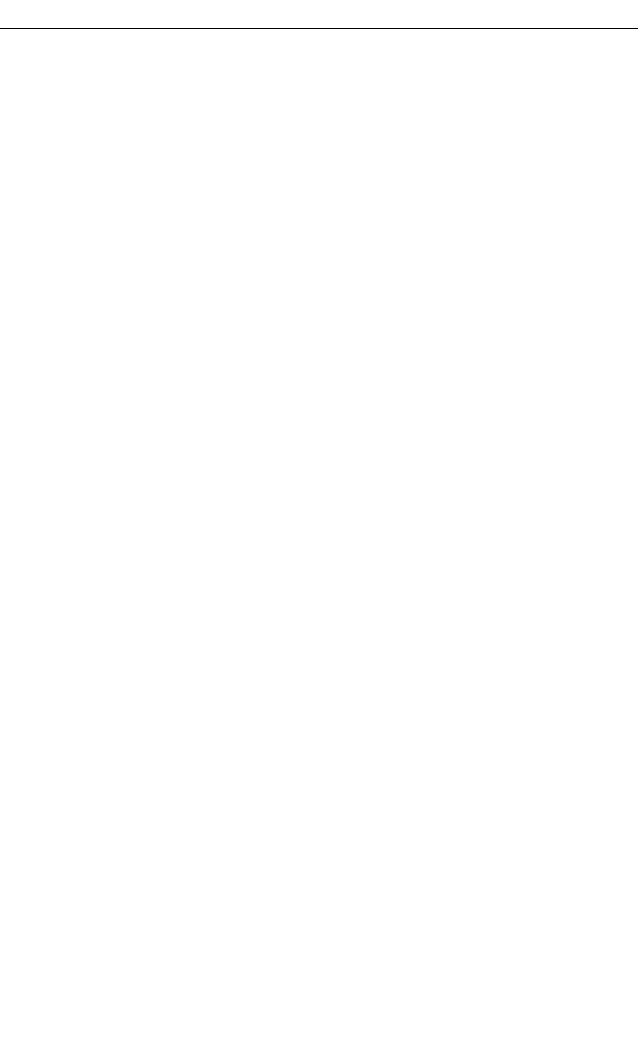
Figure S2 Distribution of the score points. The scores in the groups (A) with (black bars) vs without (open bars) significant findings; and (B) those with significant findings explaining headache (black bars) vs the rest of the cohort (open bars) are displayed. Data is expressed as % subjects per group. The 4-point score consisted of: syncope (2 points), vomiting (1 point), ophthalmological symptoms (1 point), and female gender (1